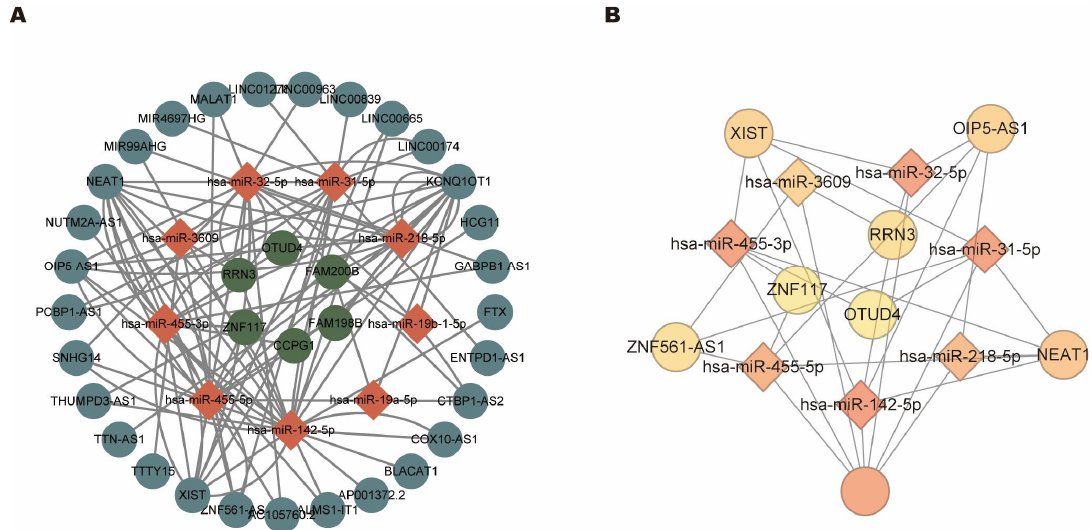
Figure 6. The competitive endogenous RNA regulatory networks. ( A ) The lncRNA-mediated ceRNA networks. ( B ) Visualization of the top 15 hub factors screened by the cytoHubba and their interaction networks.